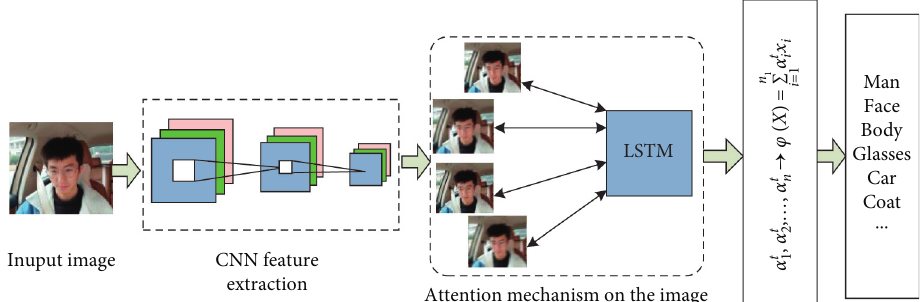
Figure 2: Image description framework of attention mechanism.